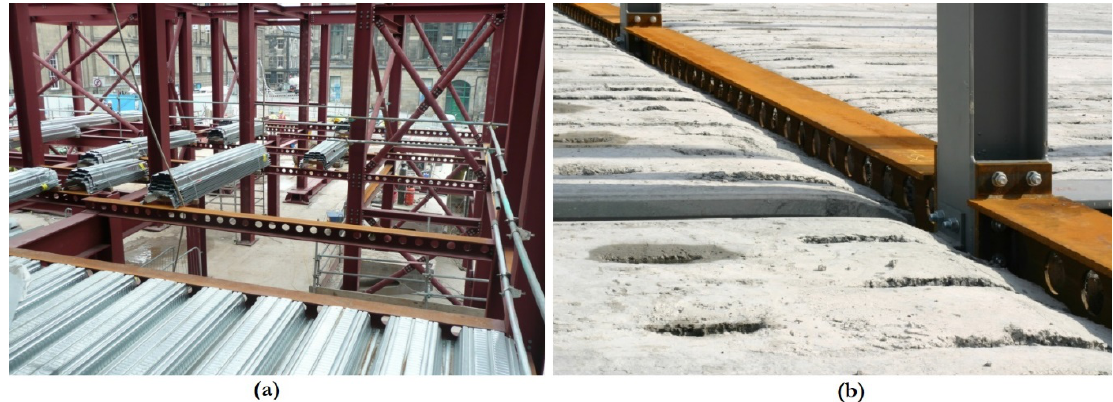
Fig. 2: Slim floor construction – (a) Steel decking [5]; (b) Precast hollow core slabs [6]